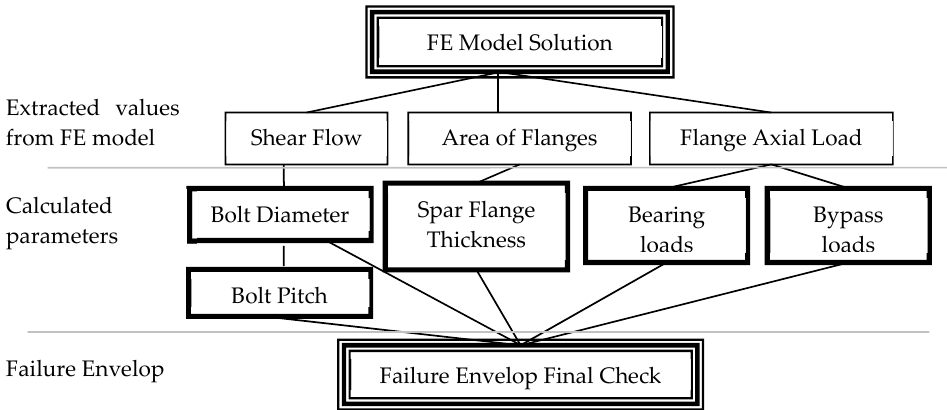
Figure 6. Flow chart of the bearing bypass bolted joint analysis.